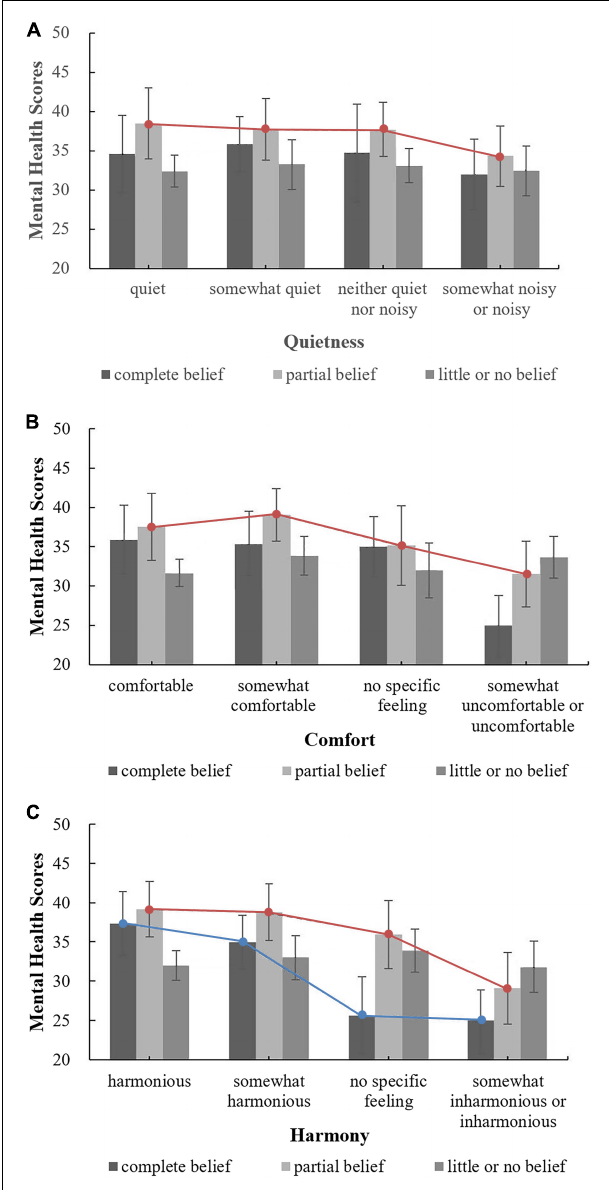
FIGURE 5 | The relationships between the evaluations of the overall acoustic environment and mental health under different frequencies. (A) Quietness; (B) Comfort; (C)